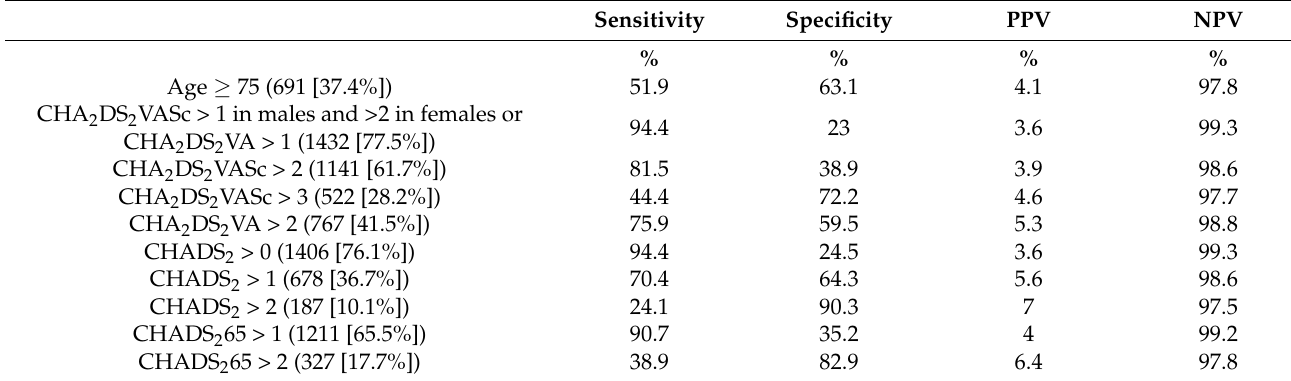
Table 3. For subjects aged ≥ 65 ( n = 1848) sensitivity, specificity, positive predictive value and negative predictive value of different cut-offs of risk stratifiers, and age ≥ 75, with regard to identification of subjects with screen-detected AF, as confirmed by 12-lead